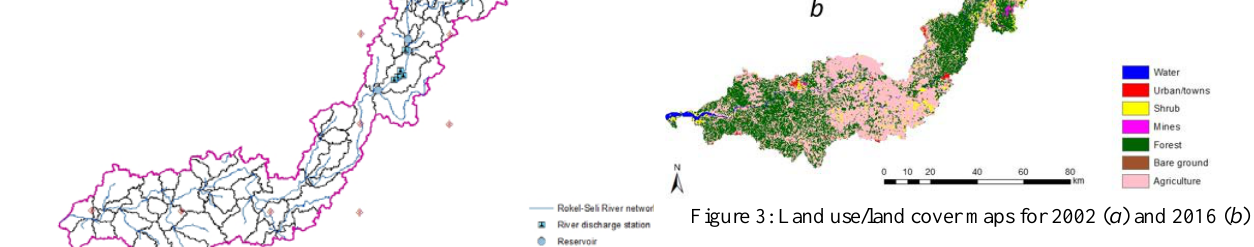
Figure 3: Land use/land cover maps for 2002 ( a ) and 2016 ( b